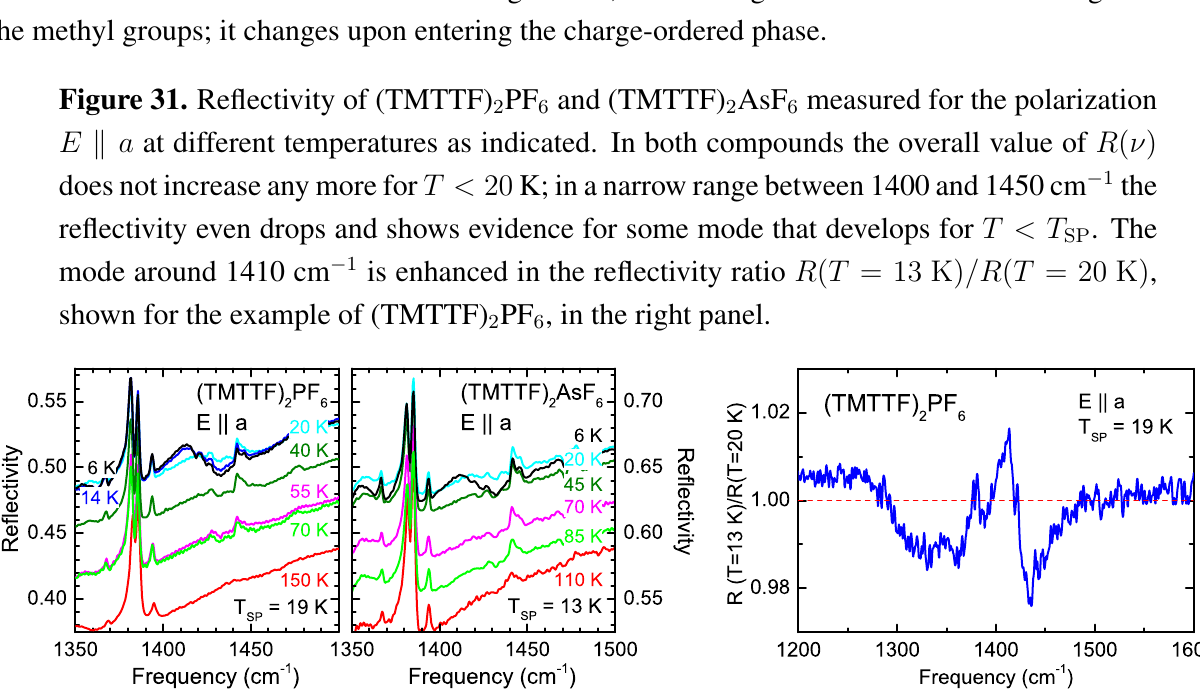
( ν ) of (TMTTF) PF and (TMTTF) AsF exhibit a feature 2 2 6 2 6